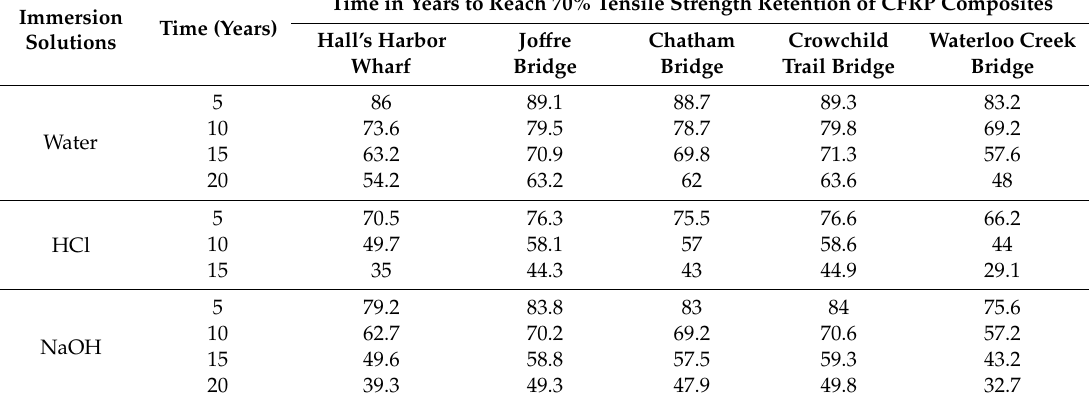
Table 10. Prediction of tensile strength retention at di ff erent annual temperatures for 25